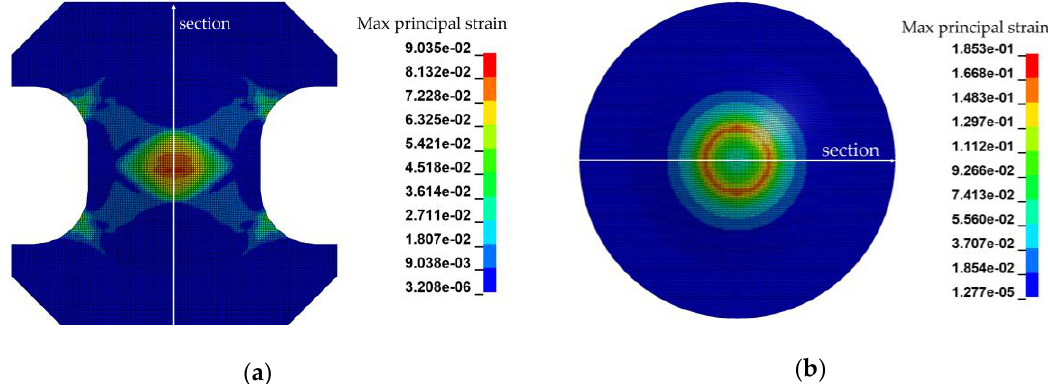
Figure 6. Finite element model results for the validation experiments ( a ) Nakajima100 specimen ( b ) limited dome height.